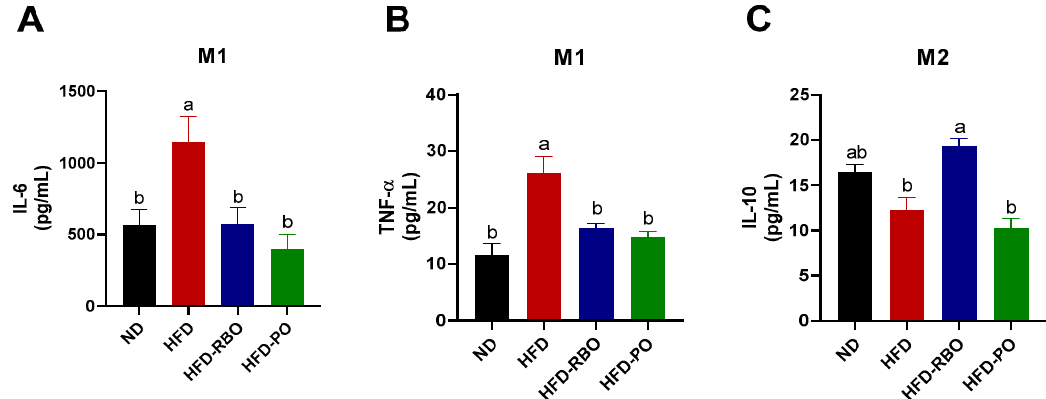
Figure 5. Cytokine expressions in M1- and M2-induced BMDMs. Levels of cytokines in polarized BMDM culture super- natants were determined by ELISA. Secretion of the pro-inflammatory cytokines ( A ) IL-6 and ( B ) TNF- α was assessed under LPS/IFN- γ -stimulated M1 conditions. Levels of the anti-inflammatory cytokine ( C ) IL-10 were quantified in IL-4/IL- 13-induced M2 BMDMs. Data are presented as means ± SEM. Significant differences are indicated with different letters ( p < 0.05) (ND, normal diet; HFD, high fat diet; HFD-RBO, high-fat diet-rice bran oil; HFD-PO, high-fat diet-palm oil).